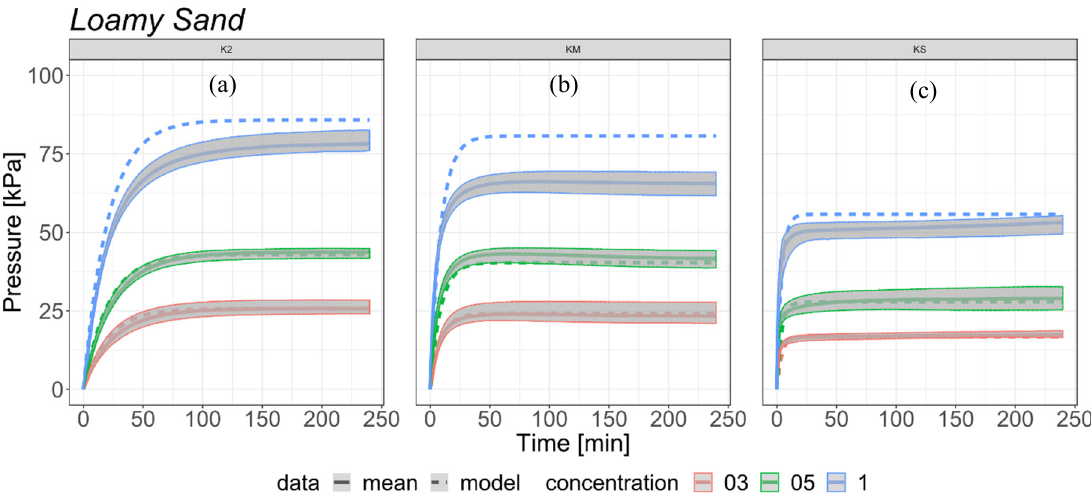
Figure 5. Comparison of the estimated model (dotted line) with measured data (continuous line) of SAP-loamy sand mixtures with range of variability (grey area) based on all experiments in the selected scenario: ( a ) K2; ( b ) KM; (c) KS.